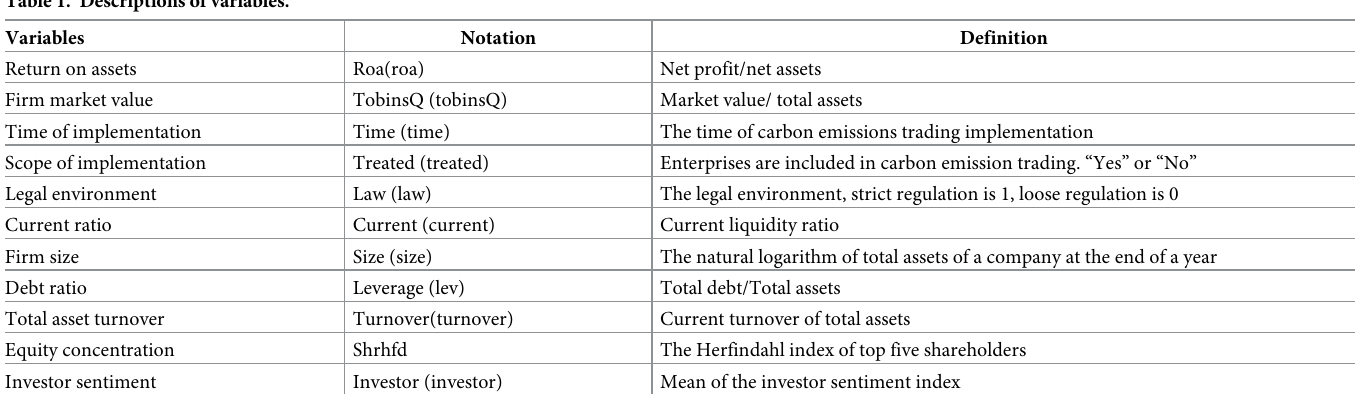
Table 1. Descriptions of